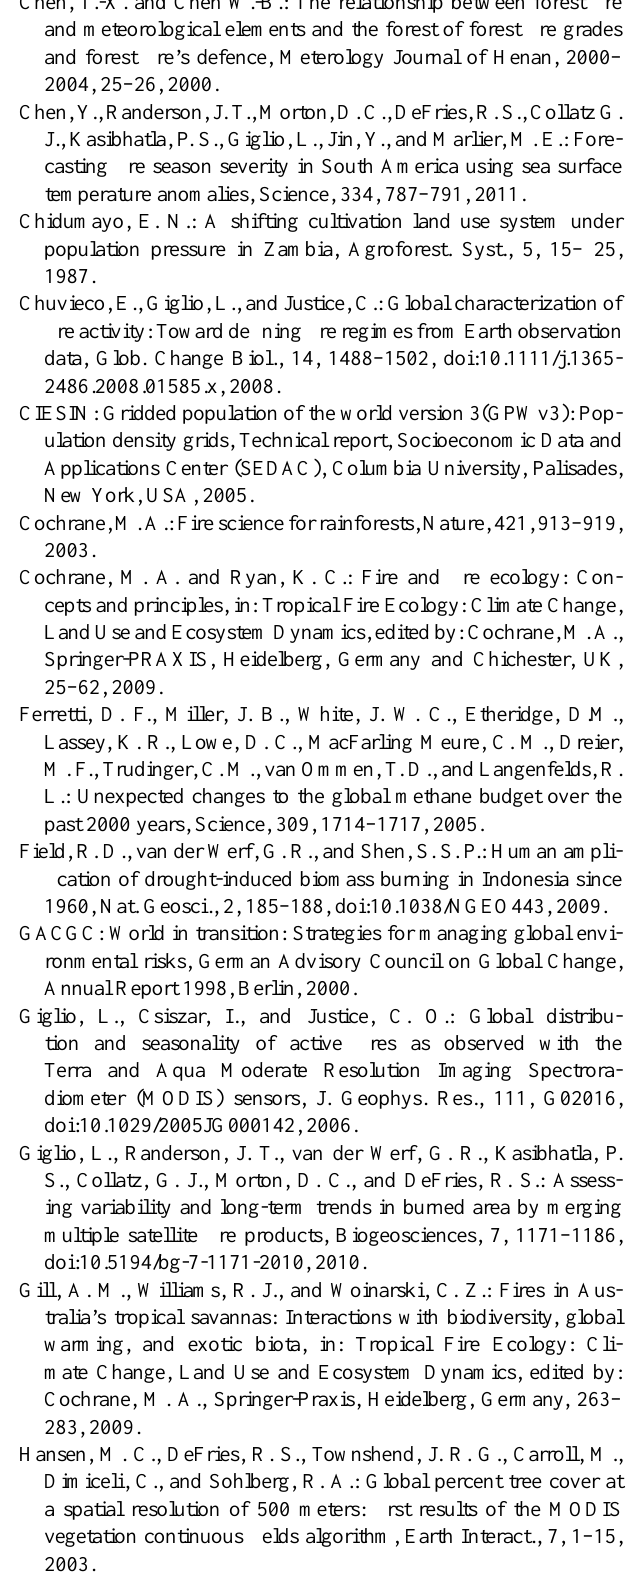
the main driver for the direct anthropogenic influence on global burned area, which led us to discover the error in our earlier CESM input data on 1850–2004 population